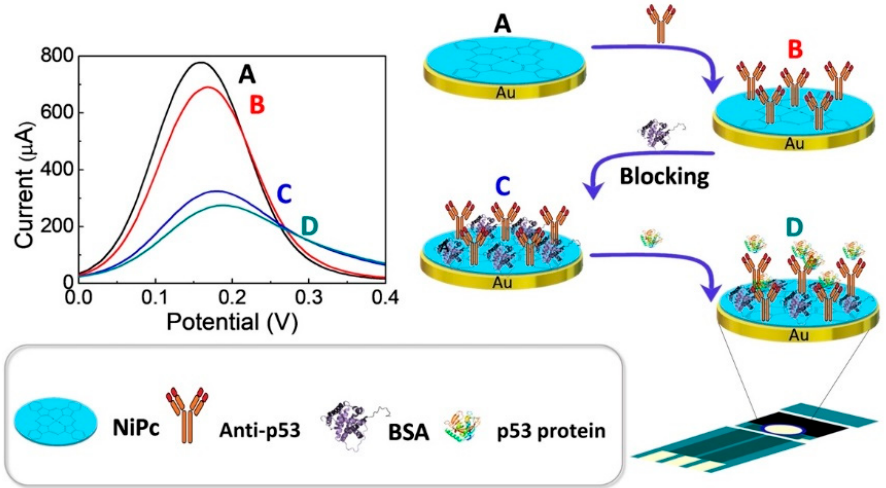
Figure 1. Experimental design of the electrochemical sensor. DPV curves of ( A ) Au/NiPc electrode, ( B ) Au/NiPc/anti-p53 electrode, ( C ) Au/NiPc/anti-p53/BSA electrode, and ( D ) Au/NiPc/anti-p53/BSA/VEGF electrodes.